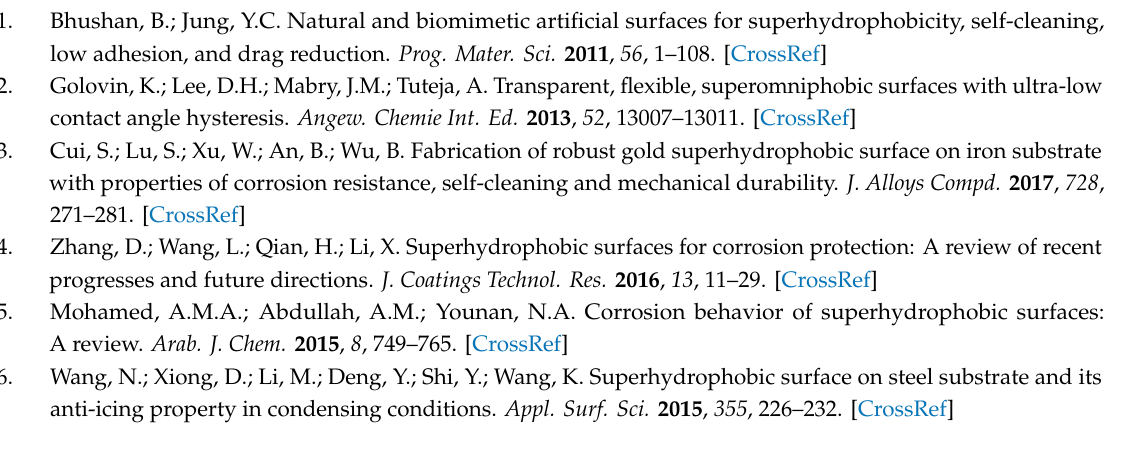
Table S1: Equivalent circuit value for PVDF base coating, Table S2: Equivalent circuit for coating C1, Table S3: Equivalent circuit for coating C2, Table S4: Equivalent circuit for coating C3, Table S5: Equivalent circuit for coating C4, Table S6: Equivalent circuit for coating C5, Video S1: Coating superhydrophobicity in